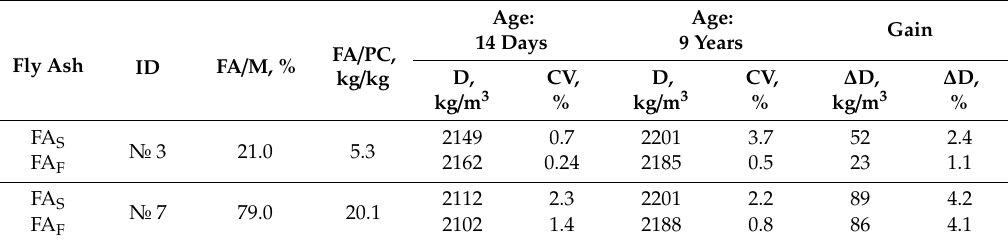
Table 3. Density of composites with various fly ashes (FA S , siliceous fly ash; FA F , fluidized fly ash) determined after 14 days and 9